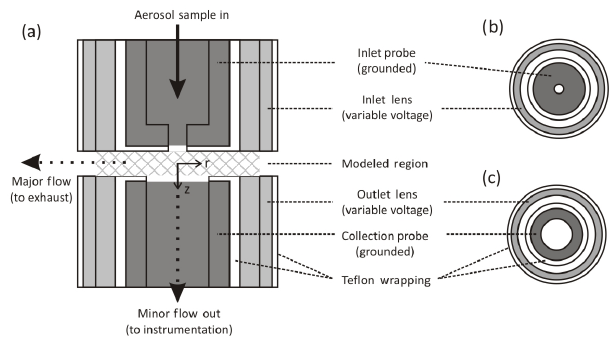
Figure 1. Schematic of the prototype electrostatic concentrator per- pendicular to flow (a) , down the inlet probe (b) , and down the col- lection probe (c) . Dark grey regions are grounded, white regions are PTFE insulation, and light grey regions are at variable